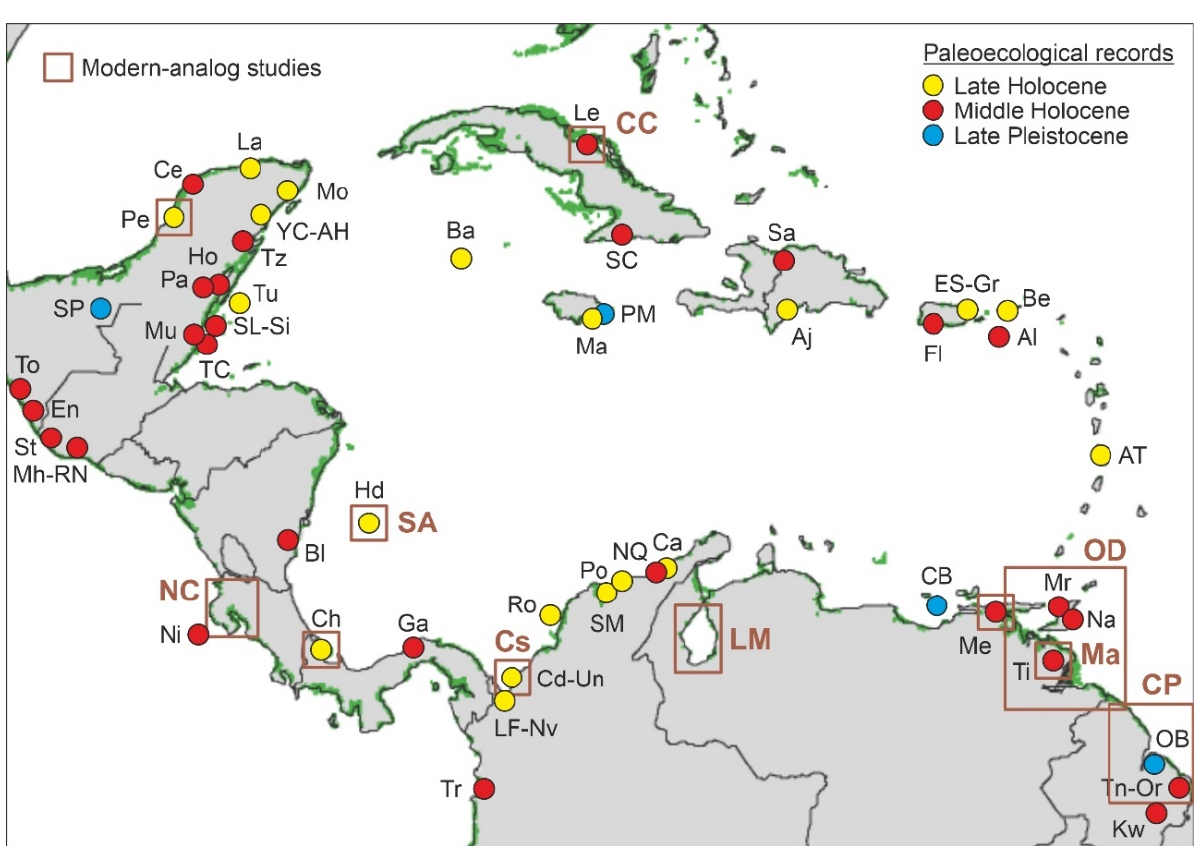
Figure 12. Circum-Caribbean sites and areas with Pleistocene–Holocene mangrove records (dots) and modern-analog pollen studies (boxes). Dot colors indicate the oldest age of each record. Abbreviations of paleoecological sites according to Table 3. Modern-analog study sites: CC, Cayo Coco (Cuba) [132]; Ch, Changuinola (Panama) [133]; CP, coastal plain (Guyana) [131]; Cs, Cispatá (Colombia) [134]; LM; Lake Maracaibo (Venezuela) [135]; Ma, Caño Macareo (Venezuela) [136]; Me, Playa Medina (Venezuela) [137,138]; NC, northwest Costa Rica [139,140]; OD, Orinoco delta (Venezuela) [130]; Pe, Petenes (Mexico) [141]; SA, San Andrés (Colombia) [142]; Ti, Caño Tigre (Venezuela) [143].